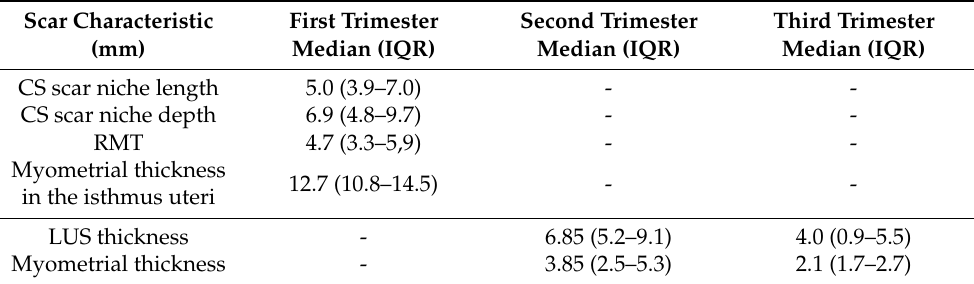
Table 2. Size of scar niche and dimensions of LUS and myometrial thickness.